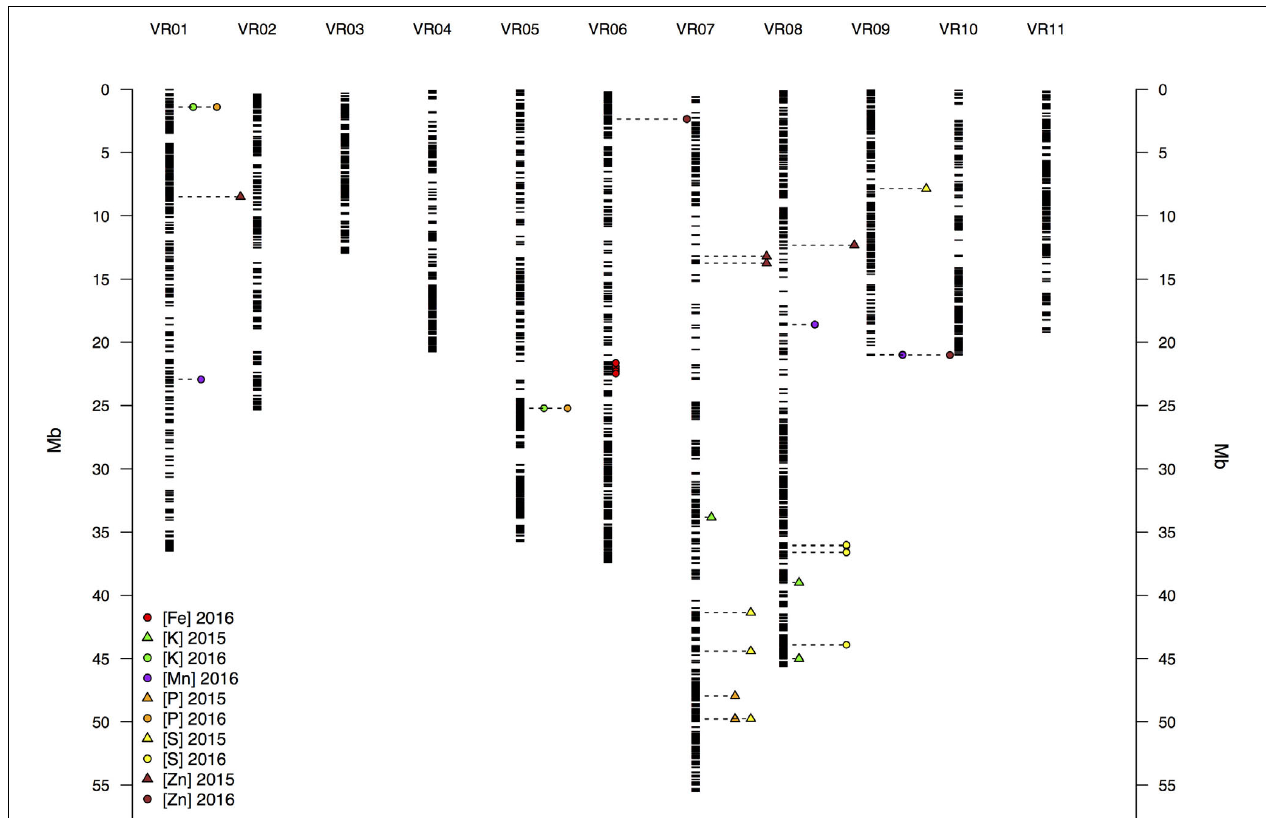
FIGURE 5 | Physical map of the 6,486 SNP markers identified by Genotyping by Sequencing (GBS) of 95 mung bean ( Vigna radiata ) accessions showing all 11 mung bean (VR) chromosomes. Physical position is shown in millions of base pairs (Mb) based on genome sequence in Phytozome. Each black hyphen corresponds to a SNP marker. The other symbols indicate SNP loci significantly associated with various seed mineral concentrations in different years according to the legend and coloring indicating each element analyzed by inductively coupled plasma (ICP) spectroscopy.